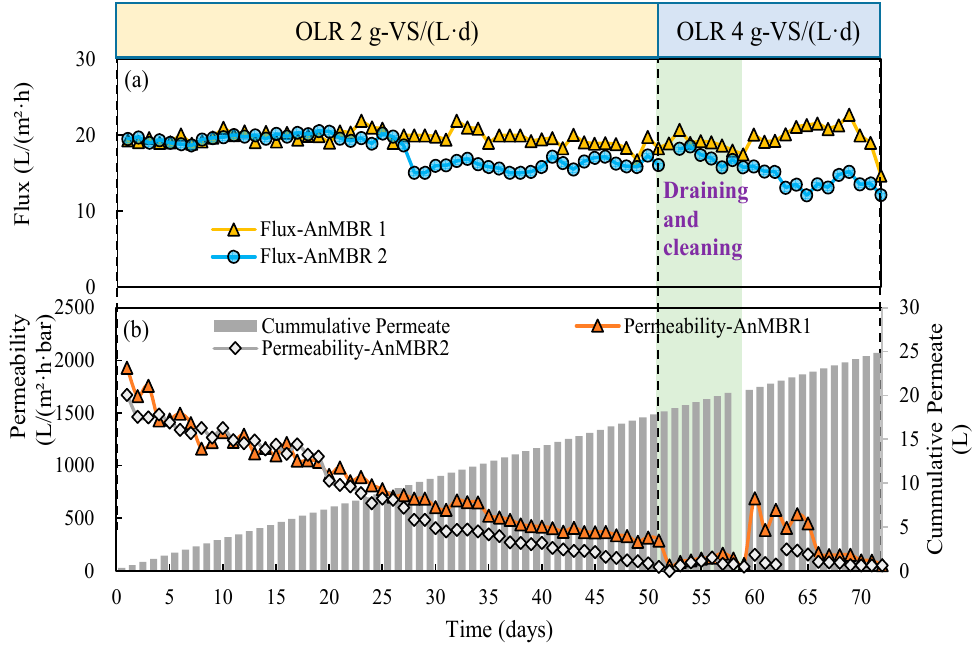
Figure 6. ( a ) Average flux and ( b ) permeability profiles in the AnMBRs during the filtration at OLRs 2 and 4 g-VS/(L·d).